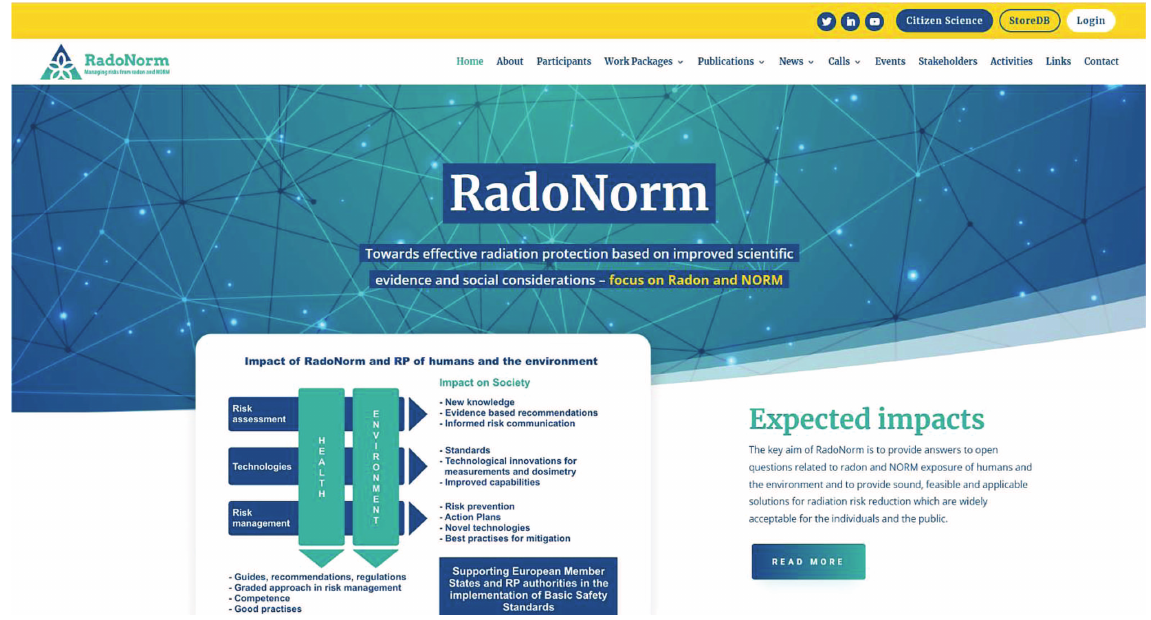
Fig. 7. RadoNorm website on public